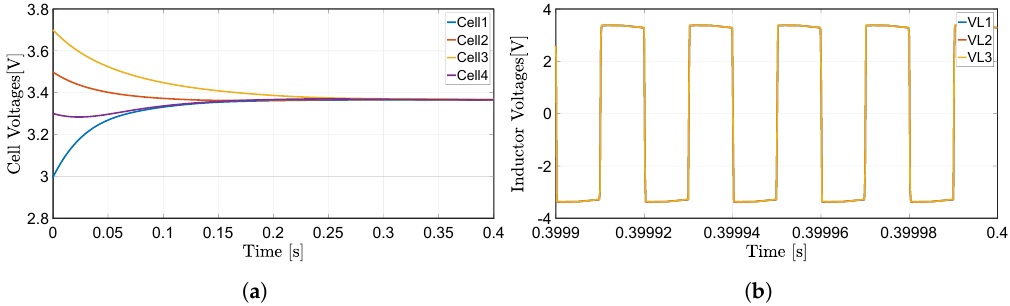
Figure 10. ( a ) Cell voltages of the proposed ´cuk balancing circuit with four cells; and ( b ) inductor voltages of the proposed ´cuk balancing circuit with four cells in steady